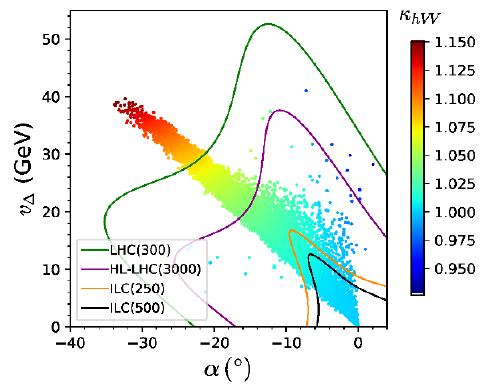
Figure 8 . Predicted value of (cid:20) section